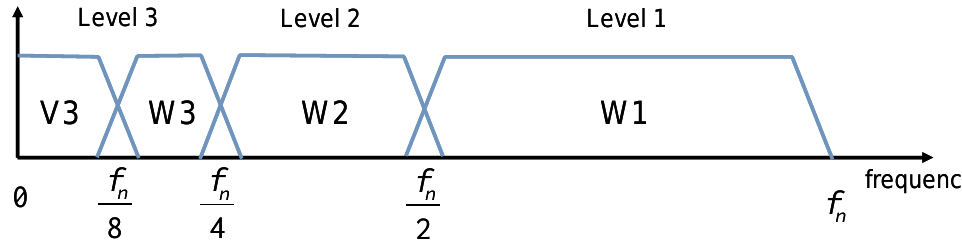
Figure 4. Frequency domain representation of MODWT levels. f frequency range of the analysed